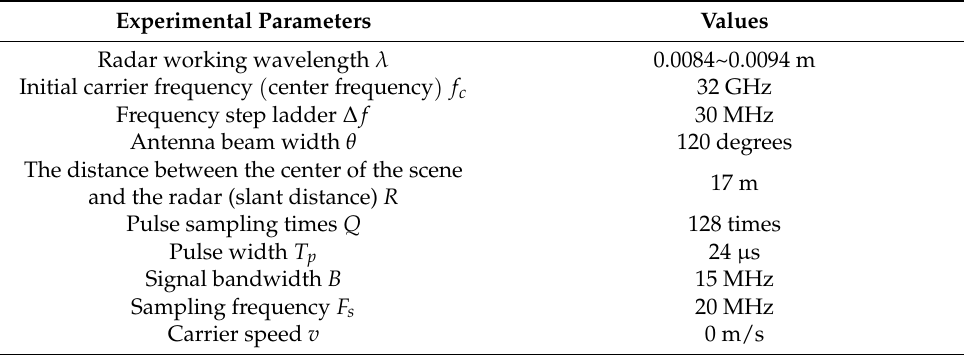
Table 1. Parameters of the radar used in the field